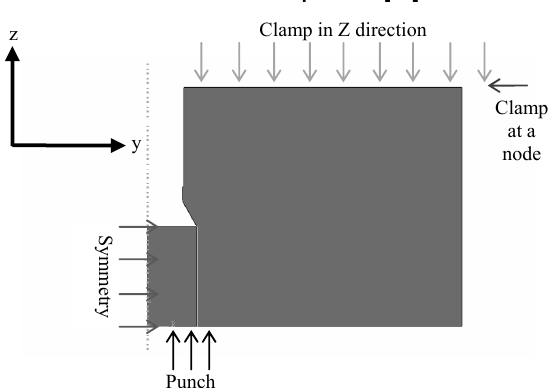
Figure 8. Illustration of full extrusion process